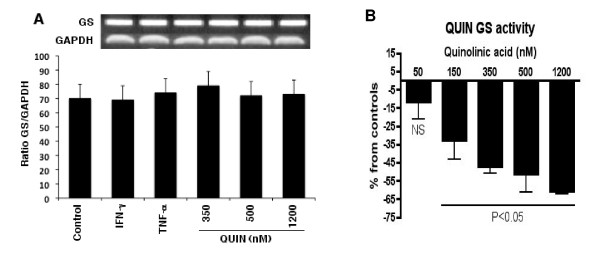
(A) Ethidium bromide-stained gel showing mRNA expression of GS and GAPDH 24 hrs after cytokine or QUIN treatments. Results are expressed as a ratio of specific gene expression normalized against expression of the housekeeping gene GAPDH. Standard errors were always 5%. (B) Glutamine synthetase activity after 24 hours stimulation with QUIN. GS enzyme assay has been done in triplicate (P < 0.05 was taken as significant).